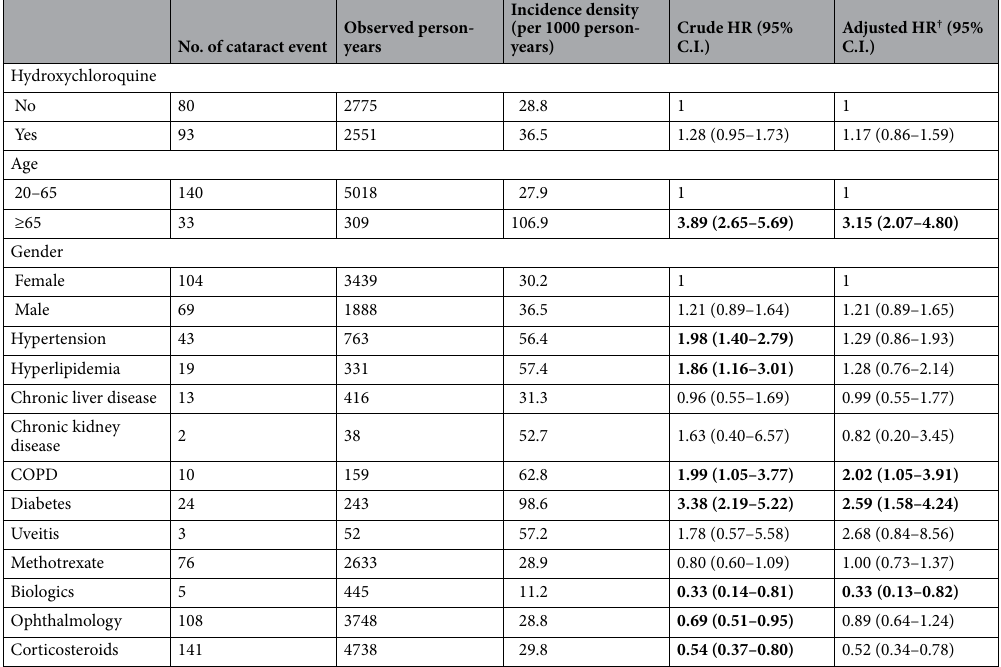
Table 2. Cox proportional hazard model for risk of cataract. Bold font represents statistical significance (p < 0.05). † Adjusted for age, gender, hypertension, hyperlipidemia, chronic liver disease, chronic kidney disease, COPD, diabetes, uveitis, methotrexate, biologics, ophthalmology, and corticosteroids.